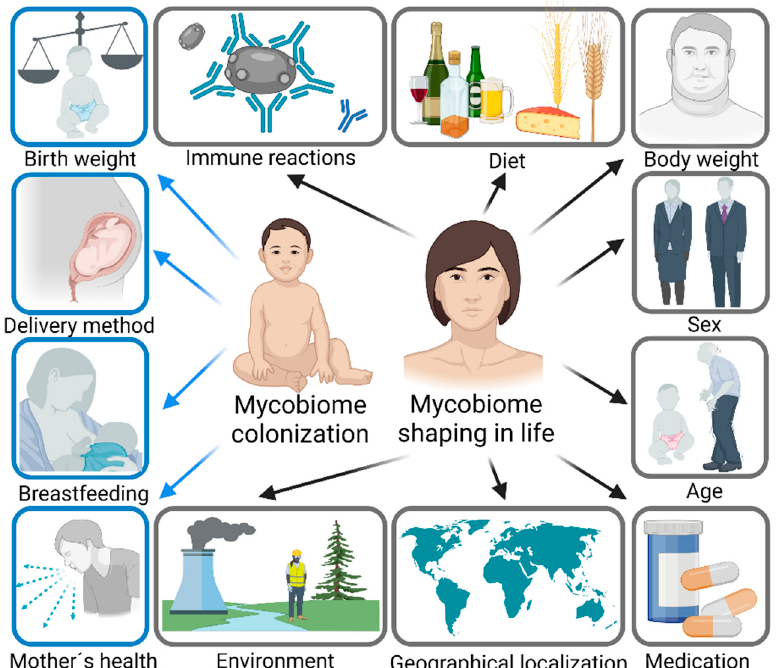
Figure 1. The main factors influencing the colonization and shaping the composition of the mycobiome in life. The colonization starts immediately after birth. Birth weight, related to gestational age, delivery method and breastfeeding vs. formula milk, as well as health and microbial colonization of relatives, can play a role. During life, the mycobiome is primarily shaped by diet, body weight, sex, age, medication and immune responses, but also the environment and geographical localization. Created with BioRender.com (accessed on 28 Septemebr